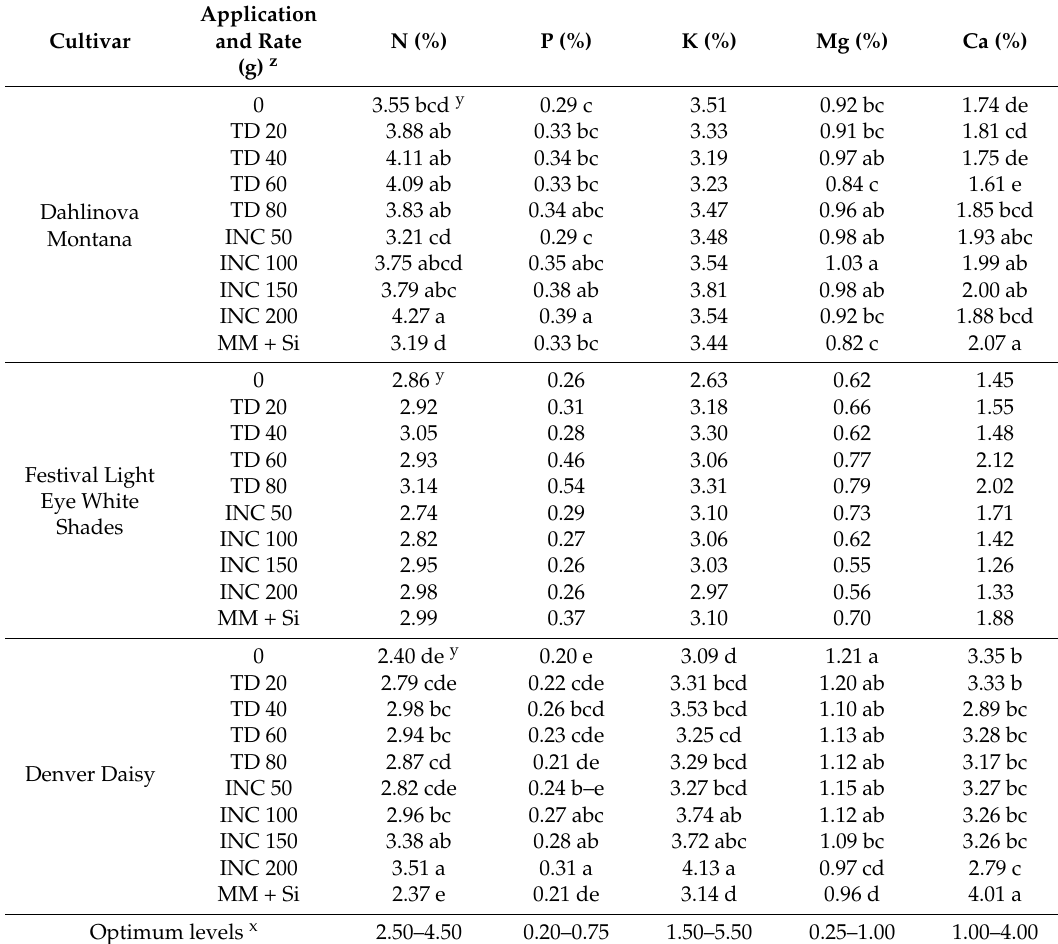
Table 5. Leaf macronutrient content affected by diatomaceous earth treatment across irrigation, controlled by a tensiometer, in Dahlia × hybrida ‘Dahlinova Montana’, Gerbera jamesonii ‘Festival Light Eye White Shades’, and Rudbeckia hirta ‘Denver